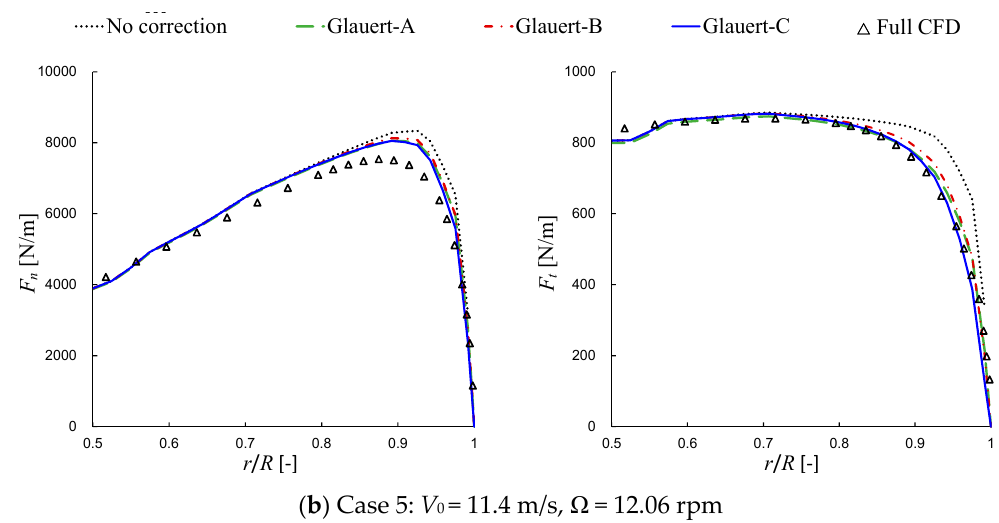
Figure 6. Normal force F n and tangential force F t along the NREL 5MW blade.